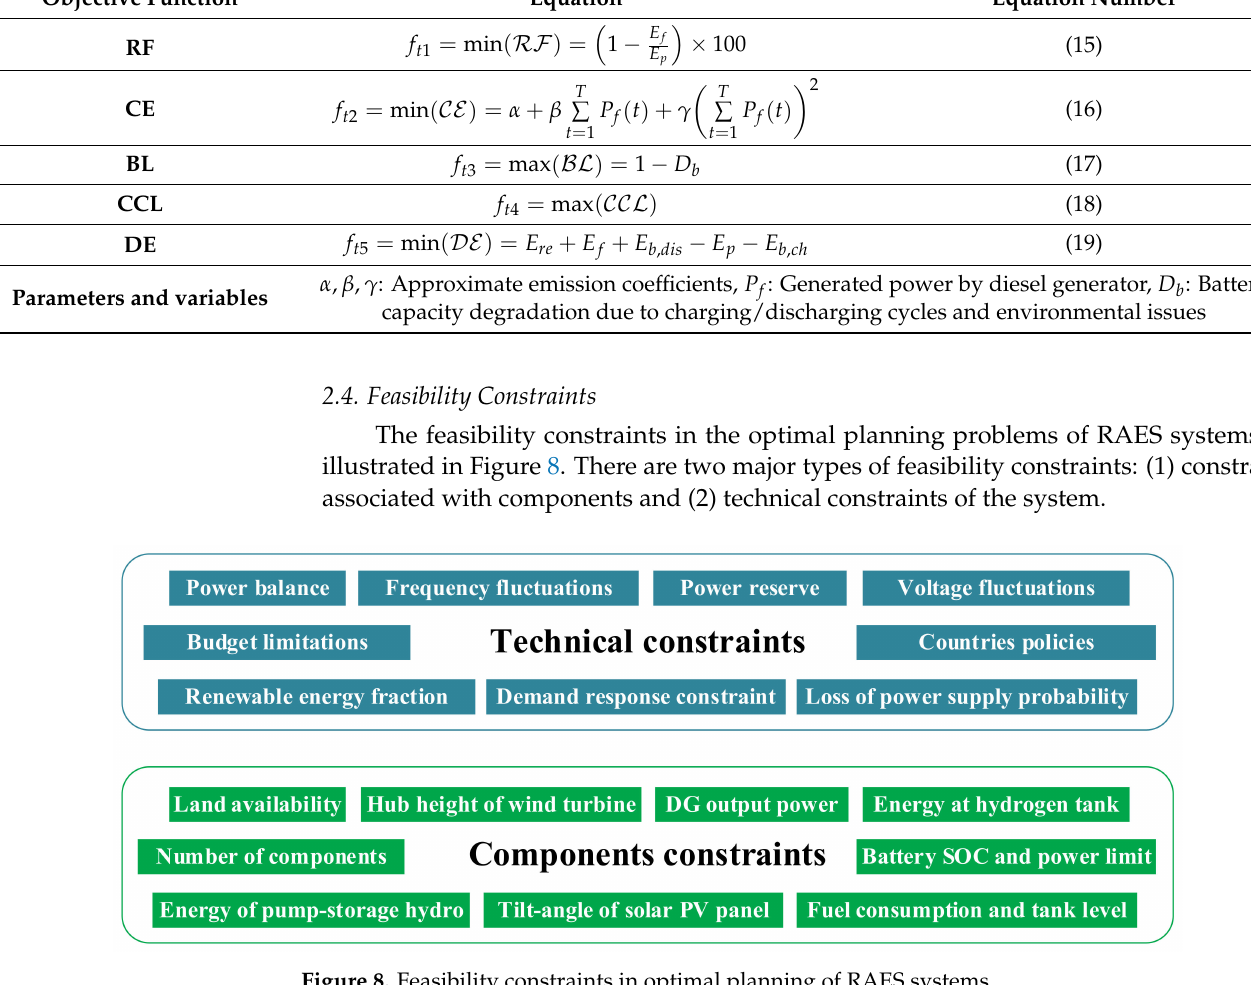
Table 3. The mathematical formulations of the emission and technical objective functions for the RAES optimal planning problem. Objective Function